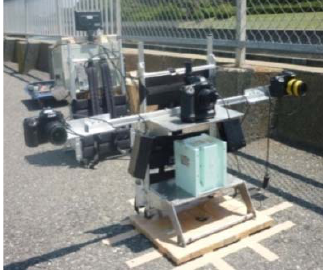
Figure 2. Inertial stereo photogrammetry